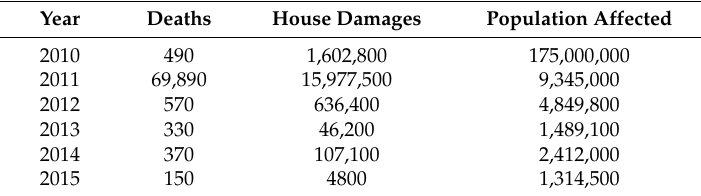
Table 1. Summary of estimated flood losses over the past few years in Pakistan.